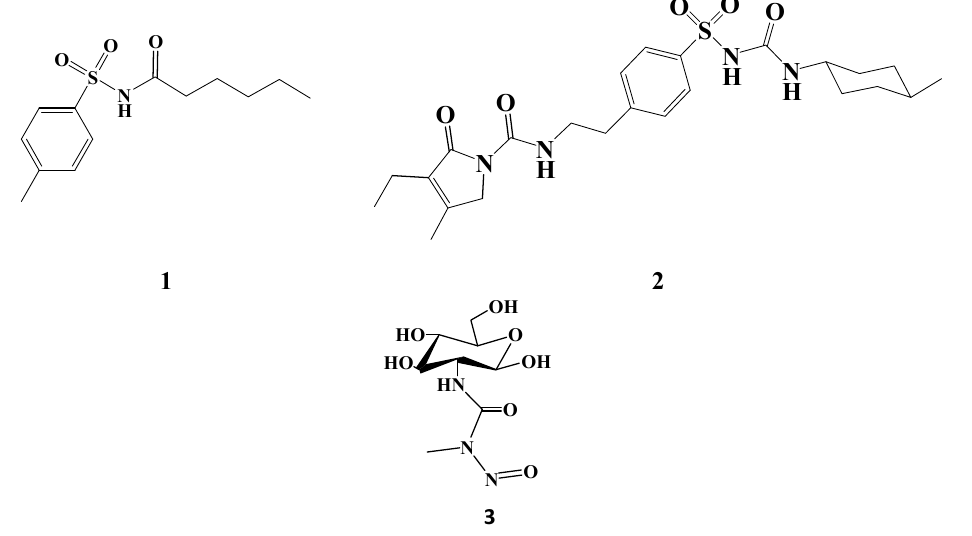
Figure 1. Chemical structures of Tolbutamide ( 1 ); Glimepiride ( 2 ) and Streptozotocin ( 3 ).